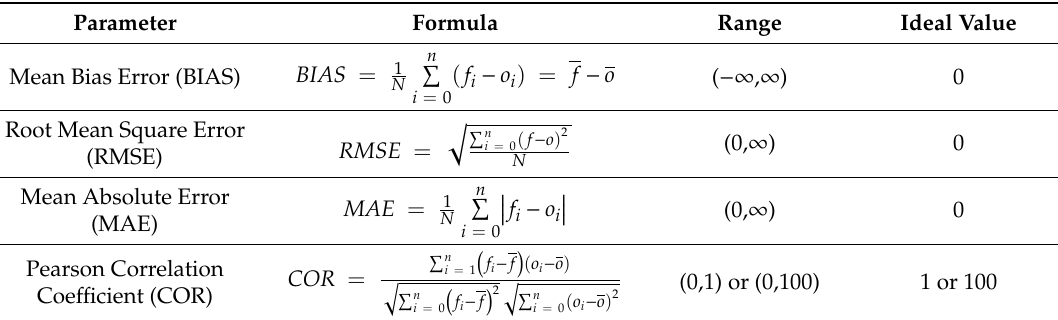
Table 2. Summary of statistical formulas calculated for model evaluation in this study.